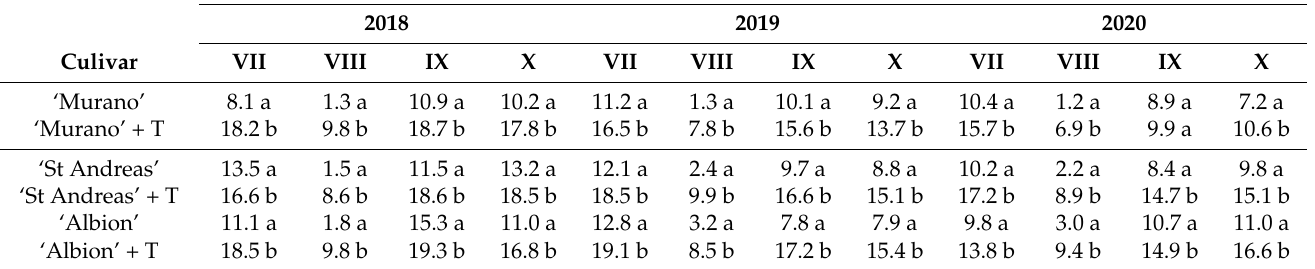
Table 3. The effect of titanium organic complex on average number of pollen grains on the stigma of three strawberry cultivars (pcs.). Average Number of Pollen Grains Germinating on a Stigma (pcs.)